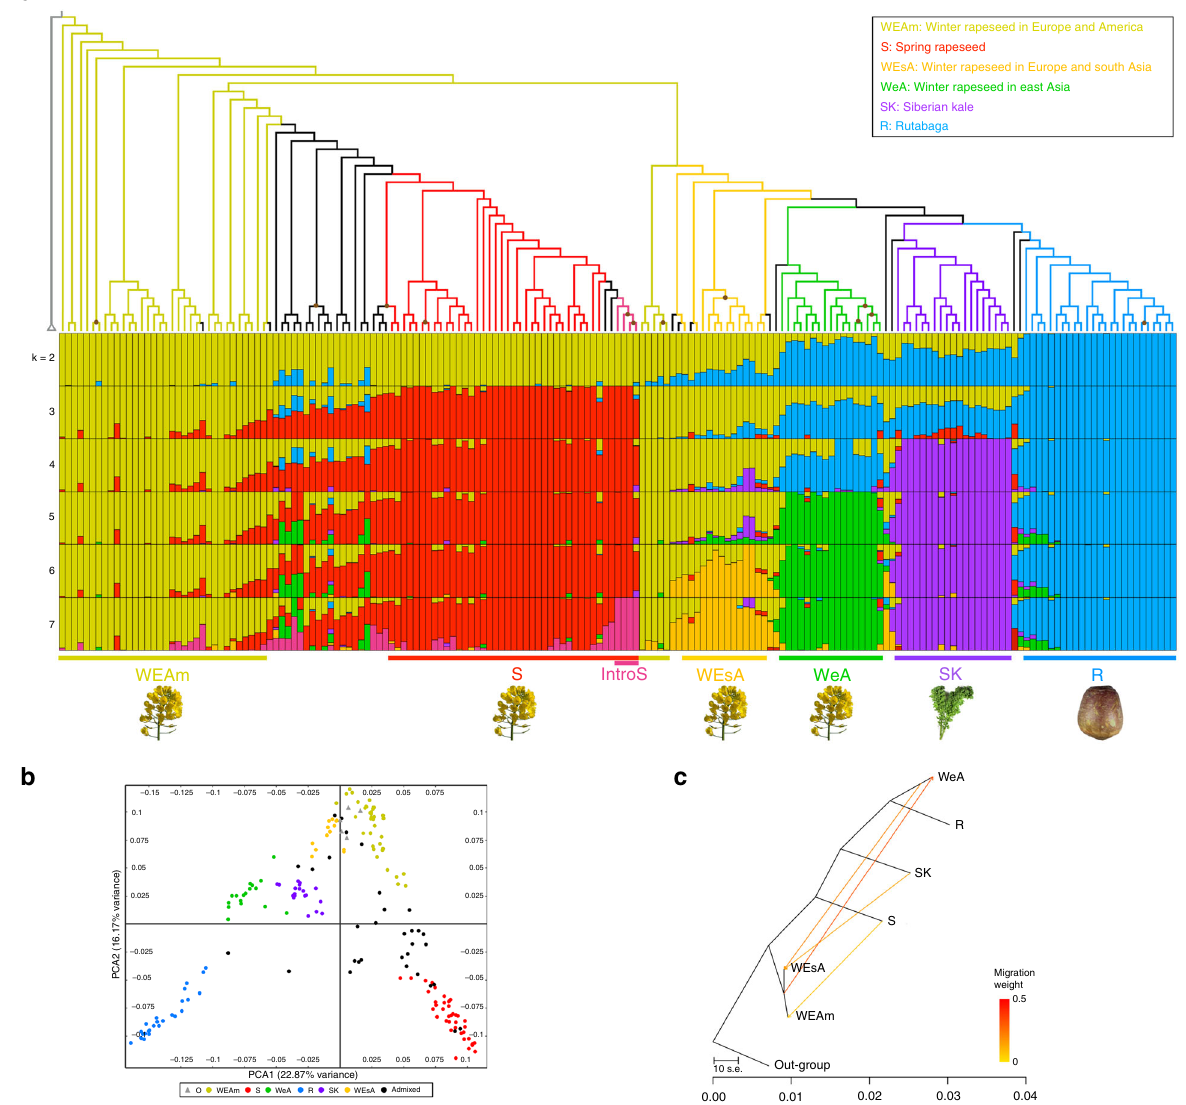
Fig. 1 Population genetics analyses of 183 B. napus accessions. a Genetic structure and maximum-likelihood phylogeny of B. napus . Five other species from Brassicaceae used to root the phylogenetic tree are shown as a single branch. The fastSTRUCTURE ancestry kinship ( K ) is shown from 2 to 7. Colors indicate different genetic clusters. Yellow: WEAm; Red: S; Orange: WEsA; Green: WeA; Purple: SK; Blue: R; Pink: IntroS (Introgressed spring rapeseed); Black: genetically diverse accessions; Dark grey: outgroup. Brown dot: bootstrap support values <70%. b Principal component analysis of the 183 B. napus and fi ve outgroup accessions. The B. napus color chart is the same as in a . Grey triangles were added to represent outgroups. c Treemix analysis of the six B. napus genetic clusters. Arrows represent the direction of migrations. Source data of Fig. 1a are provided as a Source Data fi